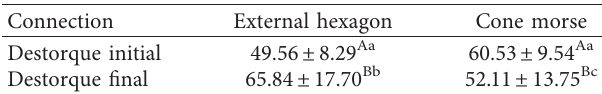
Figure 7: Graphical representation of the means and standard deviations of the torque maintenance considering the HE and MT connections and their respective alloys in the premechanical (initial destorque) and postmechanical cycling (final destorque) periods. Table 3: Means and standard deviation of the distortions as a function of different connections and periods of distortion (pre- cycling and postcycling), independent of the screw alloys.